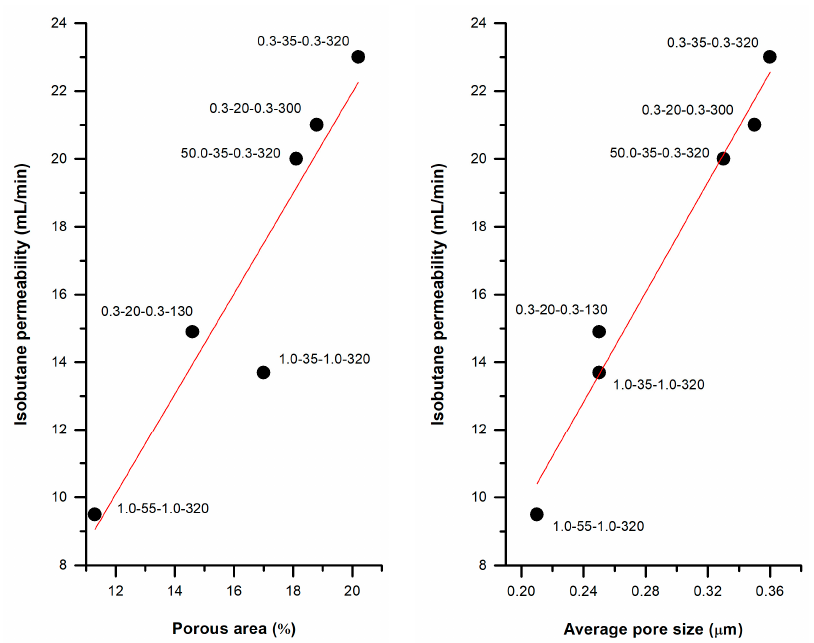
Figure 13. Isobutane permeability of some H1 membranes. Each point refers to the following sequence: crosshead speed (cold), strain extent (cold), crosshead speed (hot), strain extent (hot).